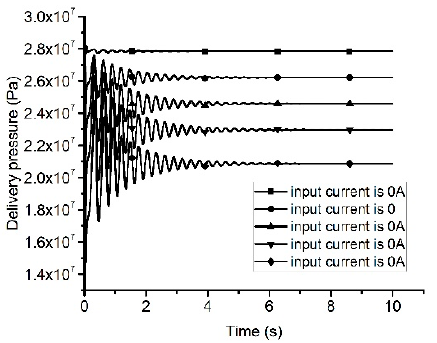
Figure 4. The delivery pressure of EHPAAPP in the case of different current signals.